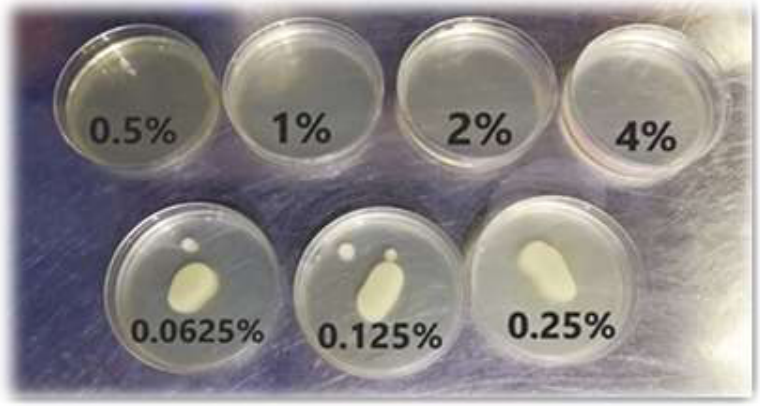
Figure 2: Tea tree oil MIC and MBC concentrations for K. pneumoniae isolates were determined through the broth dilution method was performed in a 96-well microtiter plate from 4% to 0.0625% concentration. After 24h of incubation at 37°C, 50 µL was transferred from each well to a sterile Muller Hinton agar plate and incubated at 37°C for another 24h. That showed the value of MIC was 0.25% while MBC was 0.5% .